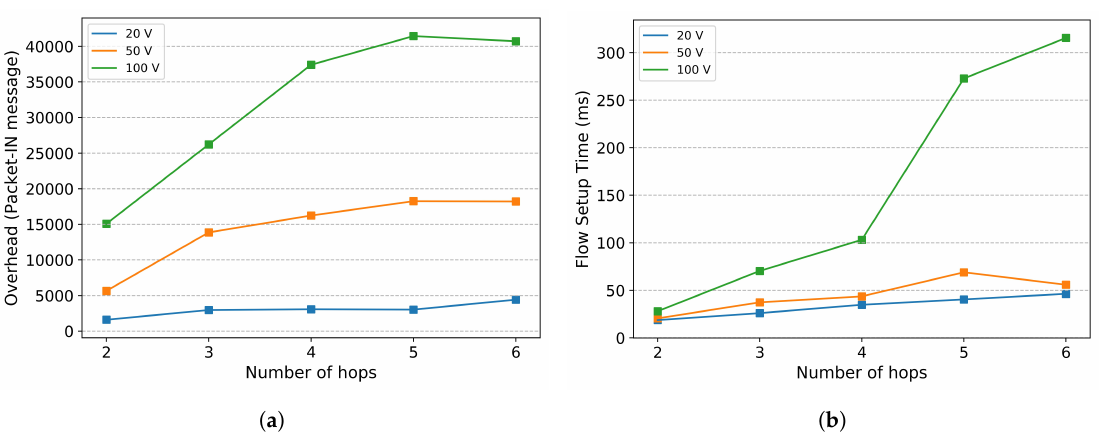
Figure 3. Placement performance. ( a ) Overhead; ( b ) Flow setup